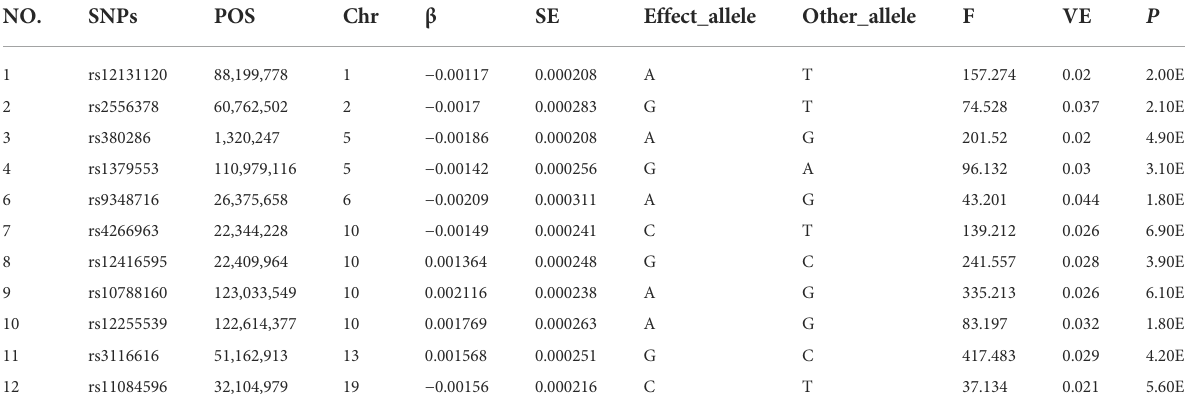
TABLE 2 MR effect size of BPH on BLCA with details of selected SNPs.